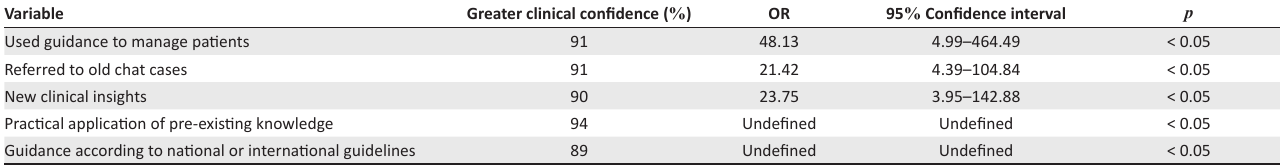
TABLE 3: Increased clinician confidence in managing patients based on their perceived usefulness of the group as a learning tool ( n = 91).